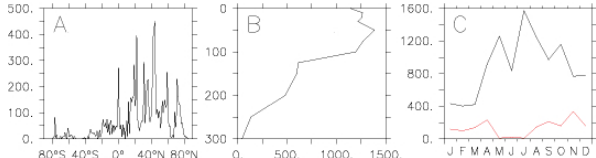
Figure 2. Number of grid points with data, as a function of (A) lati- tude. (B) Depth. Observations below 300m are not shown (1.4% of the data). The deepest observation is at 3000m and the deepest non- zero observation at 1100m. (C) Time. Red: Southern Hemisphere, black: total.